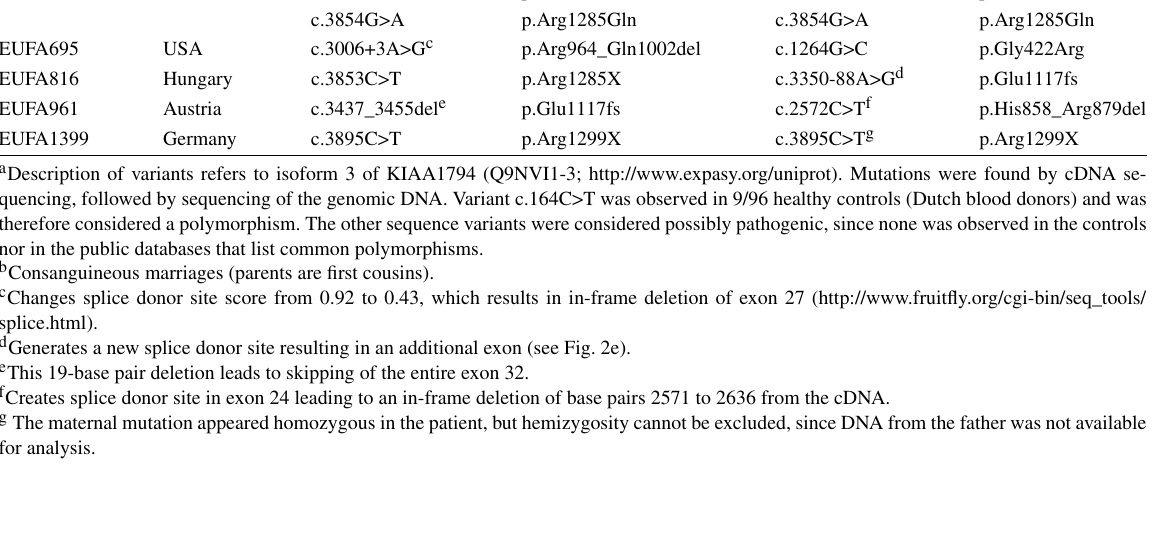
Sequence variants at the KIAA1794 locus in FA-I patients a Maternal allele Paternal allele